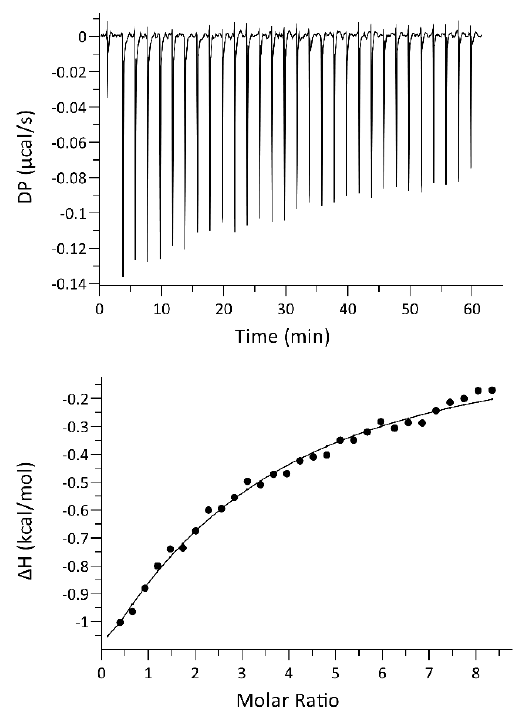
Figure 4. ITC experiment for hSR (20 μ M) titration with PSD ‐ 95 PDZ3 (600 μ M). Raw data for ITC titration ( top ) and binding isotherm of the integrated titration curve ( bottom ) were obtained at 25 °C in 50 mM HEPES buffer, pH 8.0.